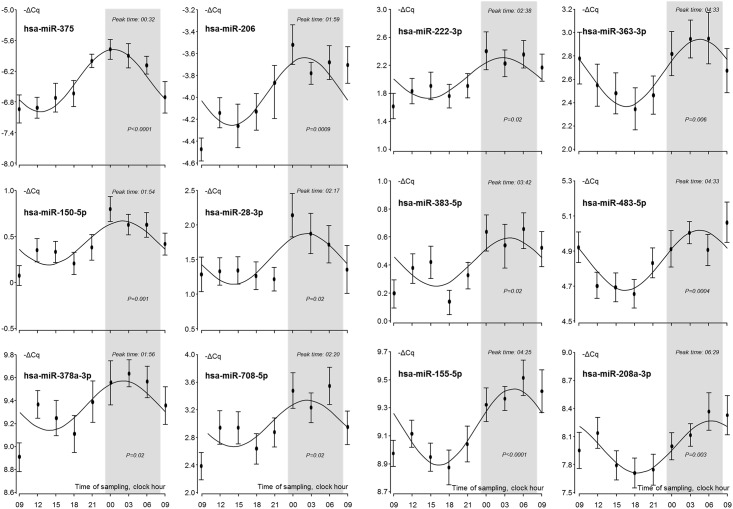
Nocturnal miRNAs.Sleep periods are indicated in grey. Individual points represent the mean and SEM of the values of the 24 test individuals.